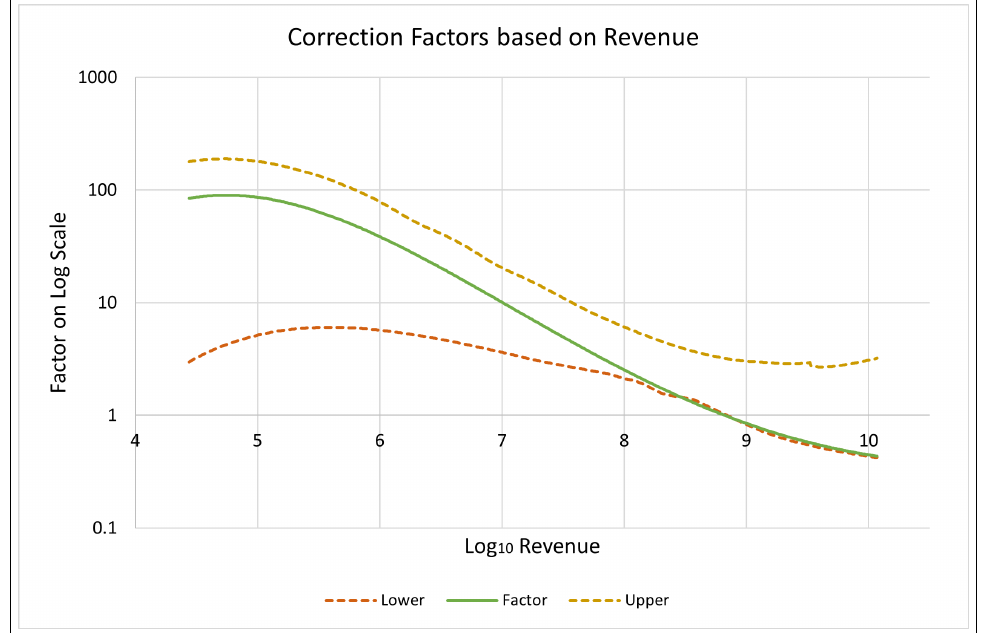
Figure 5. Under-reporting Factors: